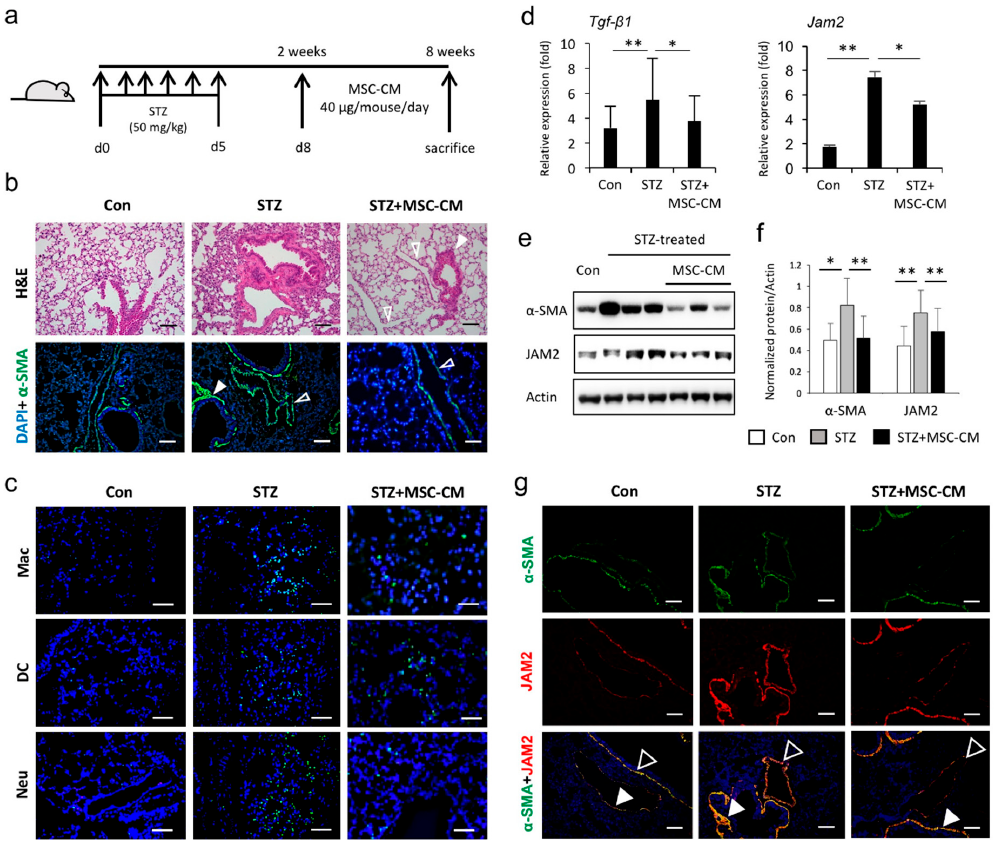
Figure 4. JAM2 is upregulated in streptozotocin (STZ)-induced diabetic mouse lung tissue. ( a ) A schematic of hyperglycemia induction using STZ and the conditioned medium from human mesenchymal stem cells (MSC-CM) treatment protocol. ( b ) Hematoxylin and eosin (H&E) and immunofluorescence staining for alpha smooth muscle actin ( α -SMA) (green) in lung sections from the Con, STZ, and STZ + MSC-CM groups. Nuclei were counterstained with DAPI (blue). Closed arrowheads indicate bronchioles while open arrowheads indicate vessels. Scale bars, 50 μ m. ( c )